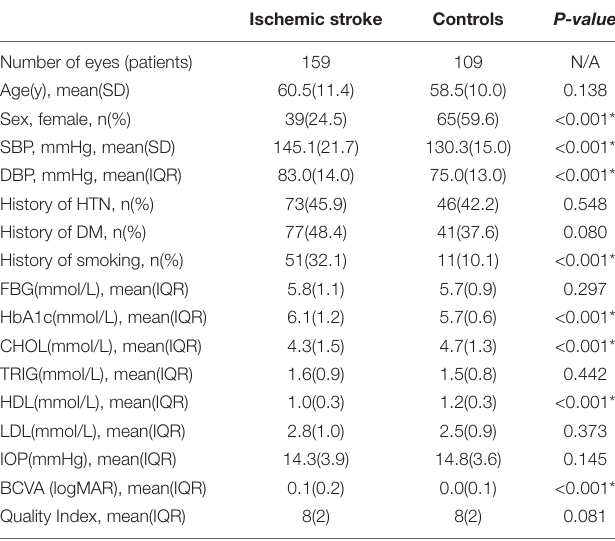
TABLE 1 | Demographic and clinical characteristics of the two